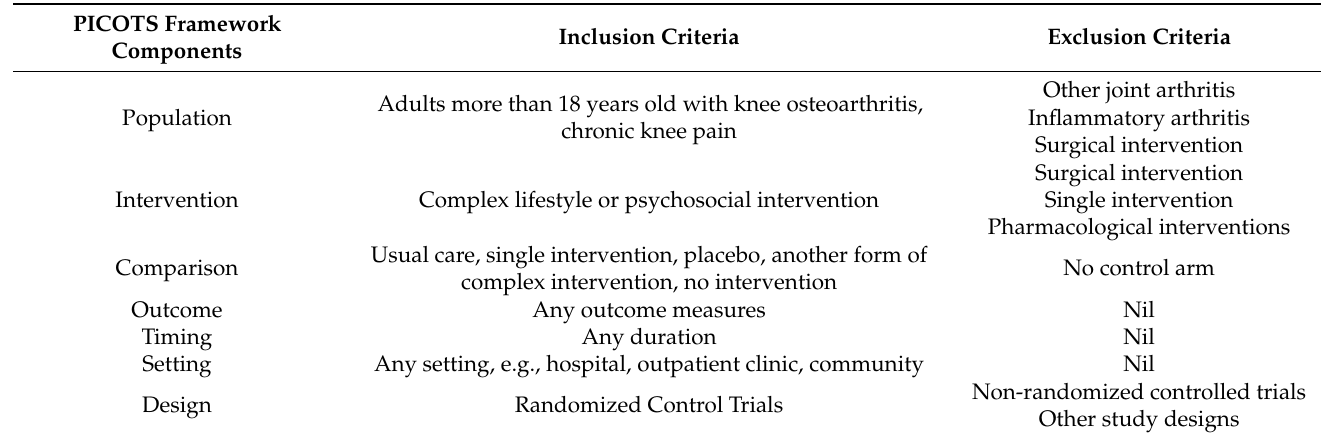
Table 1. Inclusion and Exclusion